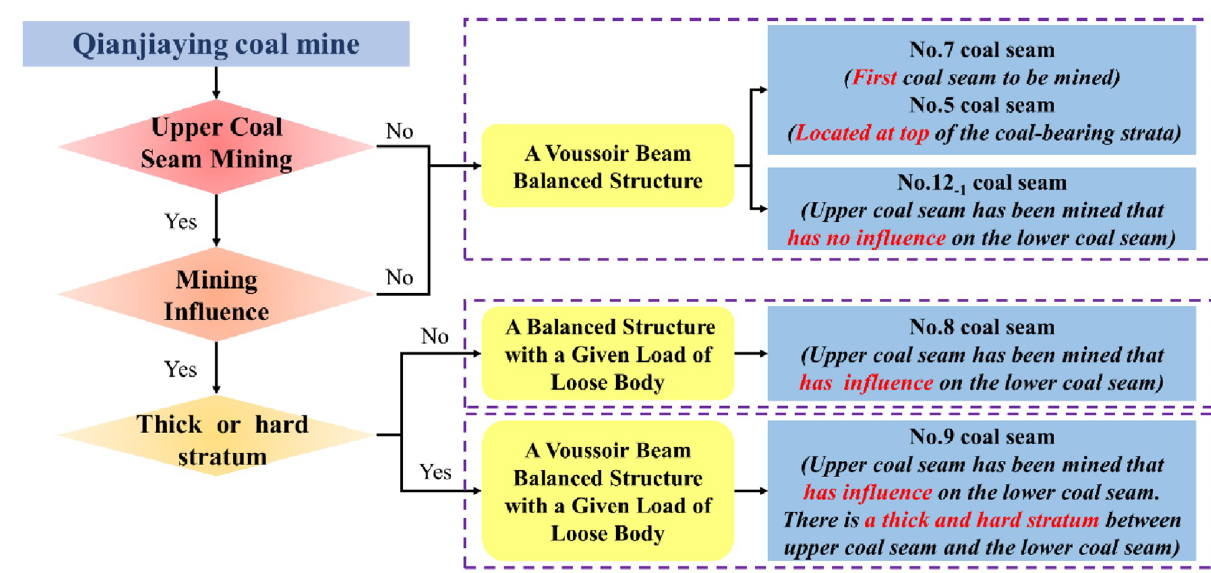
Fig 8. Roof structure calculation model of MSSC in Qianjiaying coal